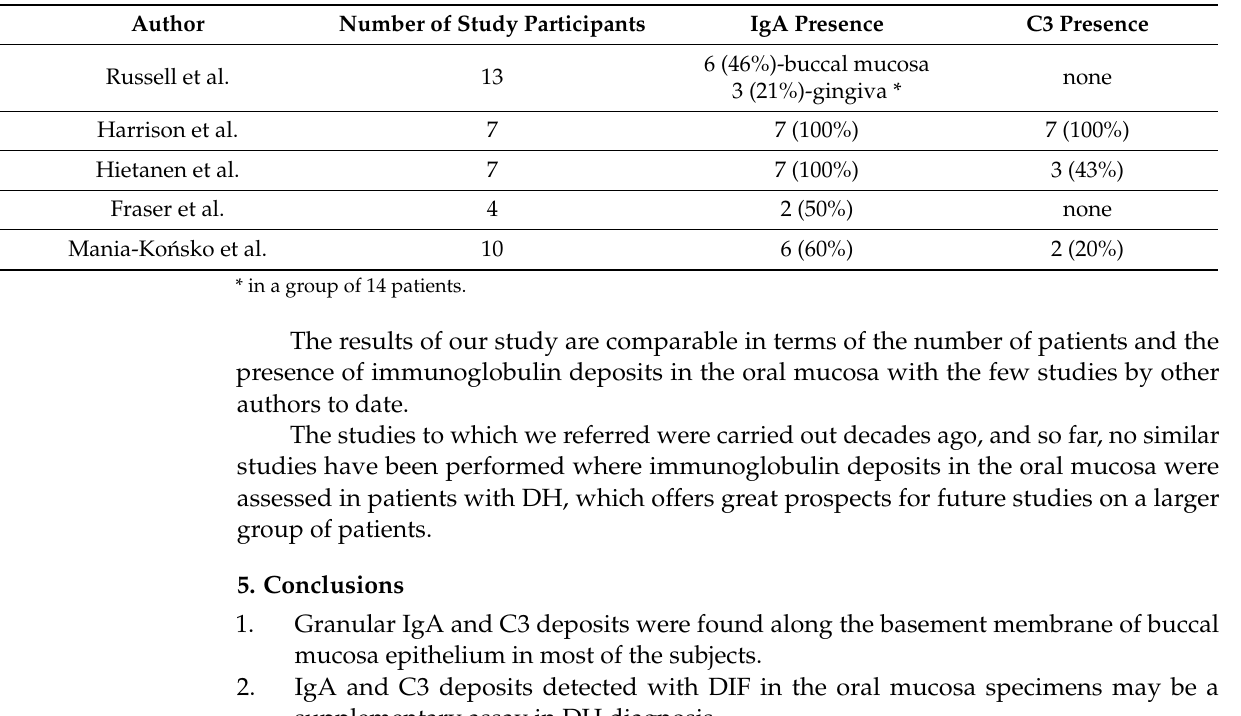
Table 2. Immunoglobulin and C3 deposits in the oral mucosa according to the present study and other authors’